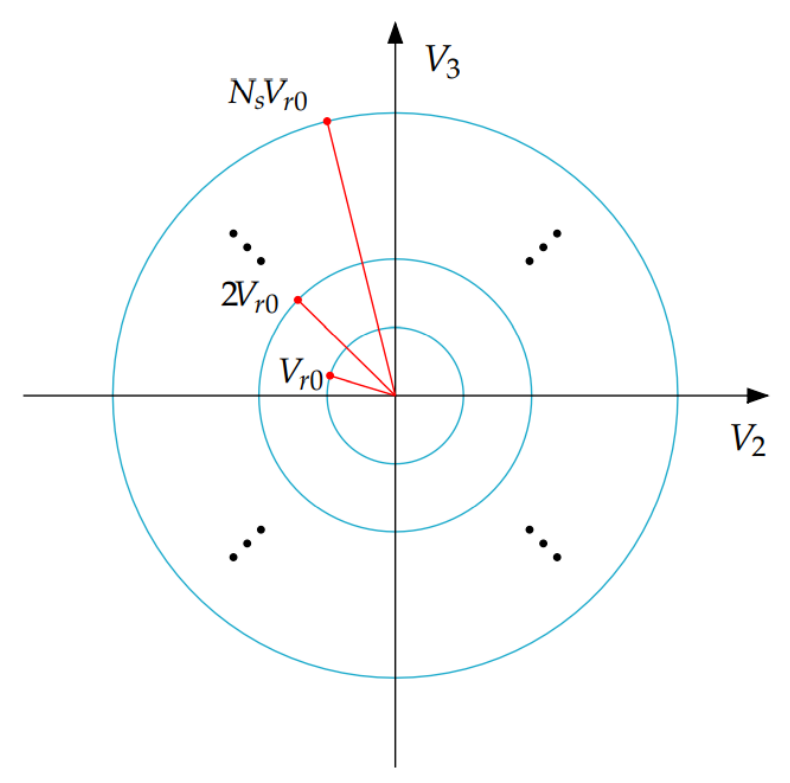
Figure 27. Circumference with varying radius N si V r 0 in the two-dimensional space for the case n = 3.